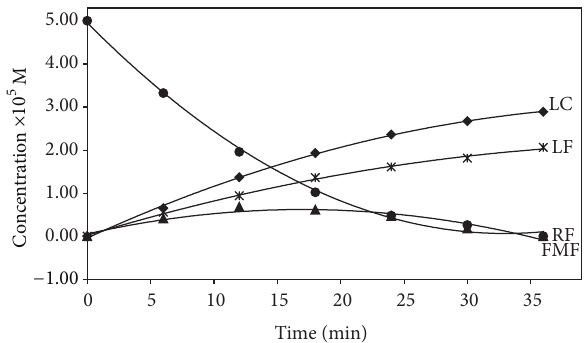
Figure 4: A plot of concentration versus time for the photodegra- dation of RF and its photoproducts at pH